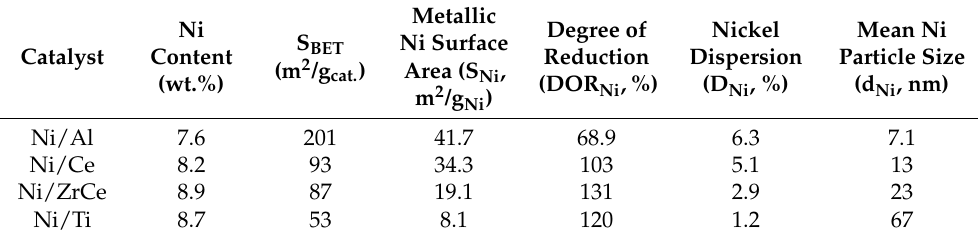
Table 1. Physicochemical properties of the supported nickel